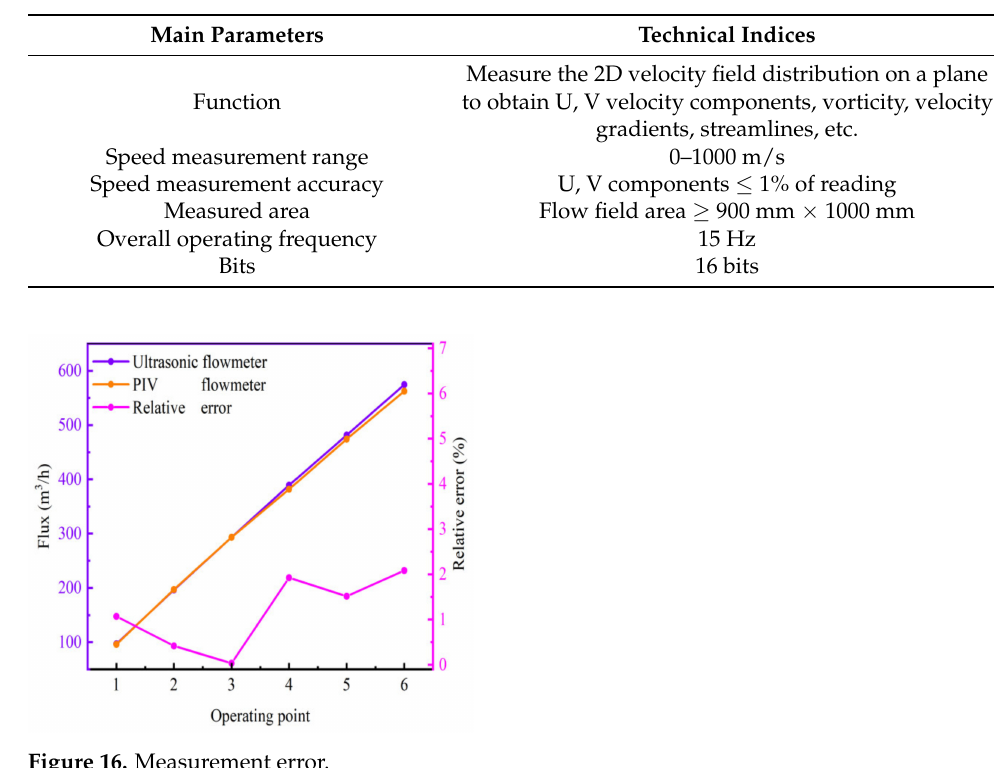
Figure 15. Field test setup. Table 1. Main technical parameters of PIV system.